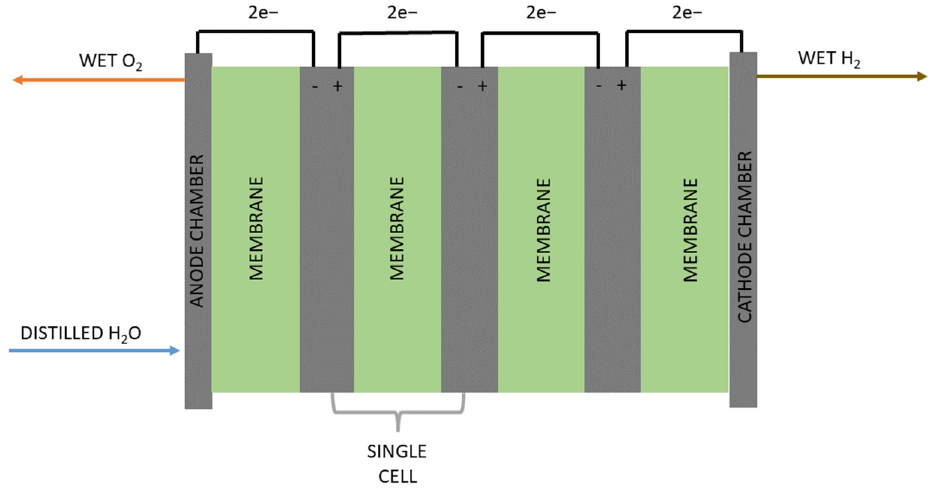
Figure 1. Structure and operation of a PEMEL.